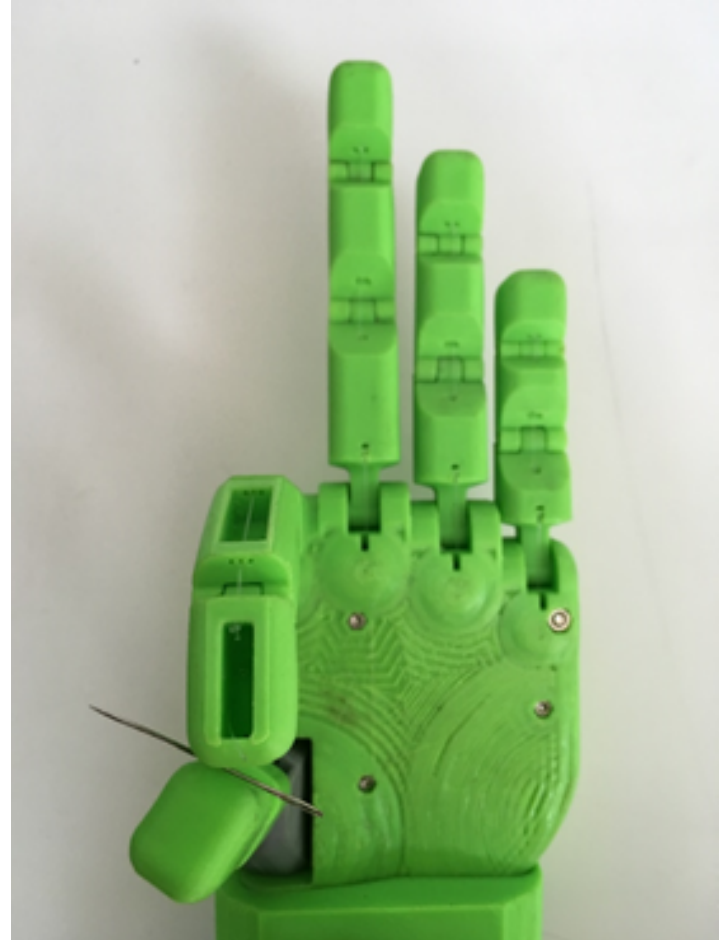
Figure 9. Prosthesis holding a needle through a bidigital opposition grip (terminal/terminal- thumbscrew